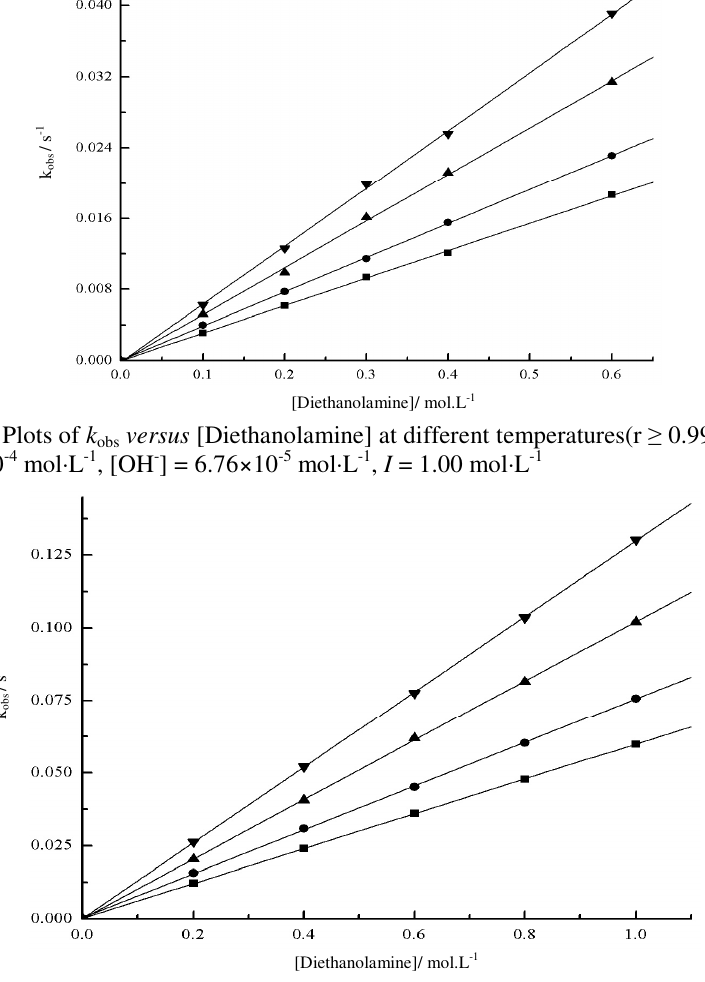
Figure 2. Plots of k versus [Triethanolamine] at different temperatures(r ≥ 0.999), obs [Fe(VI)] = 1.11 × 10 -4 mol·L -1 , [OH - ] = 1.38 × 10 -4 mol·L -1 , I = 1.00 mol·L